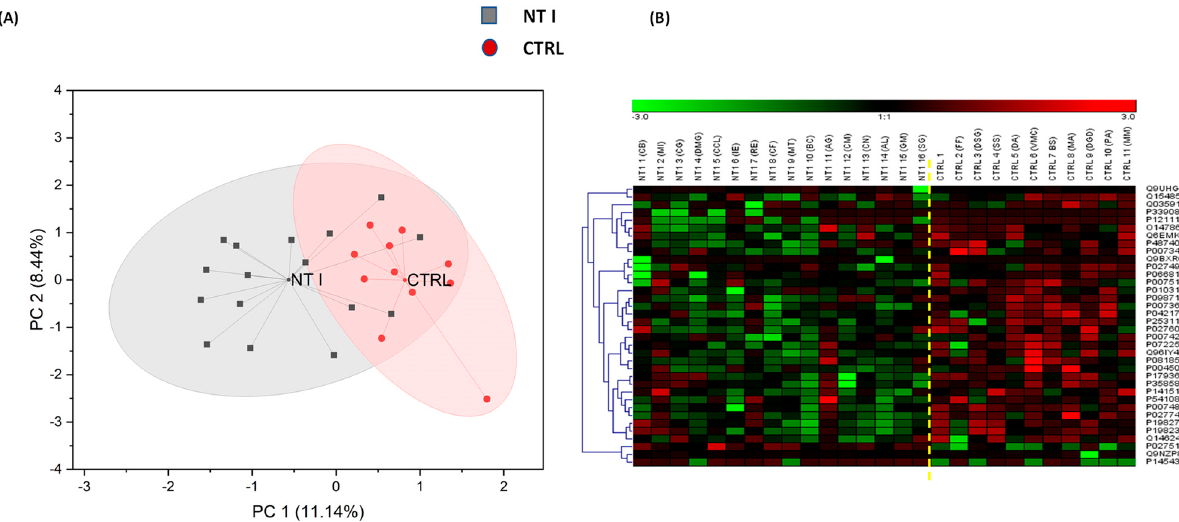
Figure 2. ( A ) Unsupervised Principal Component Analysis (PCA) of all identified proteins at a 95% confidence level and ( B ) Heatmaps for the DEPs in 16 NT1 and 11 control samples. Thirty-two DEPs are downregulated proteins in NT1, indicated by the color green, while four DEPs are upregulated, indicated by the color red. Table 2. Up- and down-regulated DEPs in NT1.